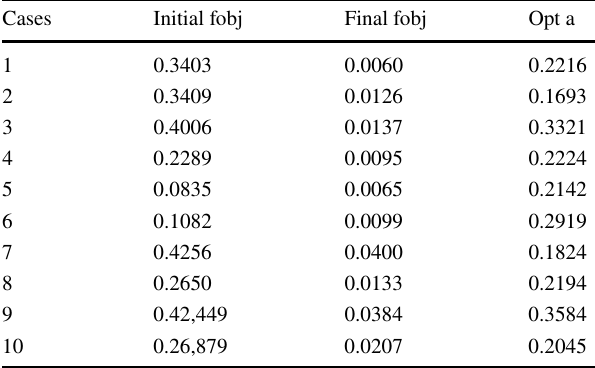
Table 3 Optimization results for 10 different initial points: initial and final objective function, optimal a